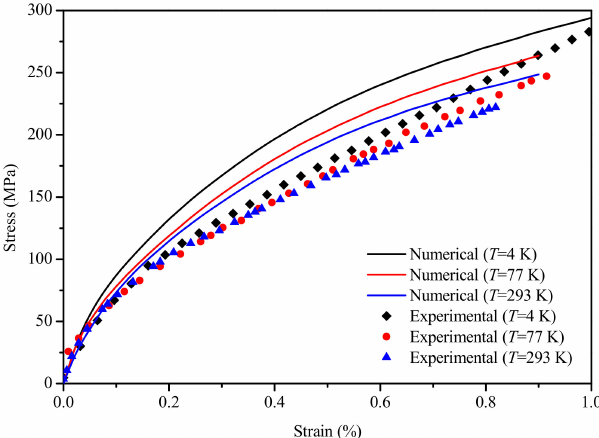
Figure 13. Numerical simulation and experimental comparison of the EAS-Nb 3 Sn strand under different working temperatures considering damage.